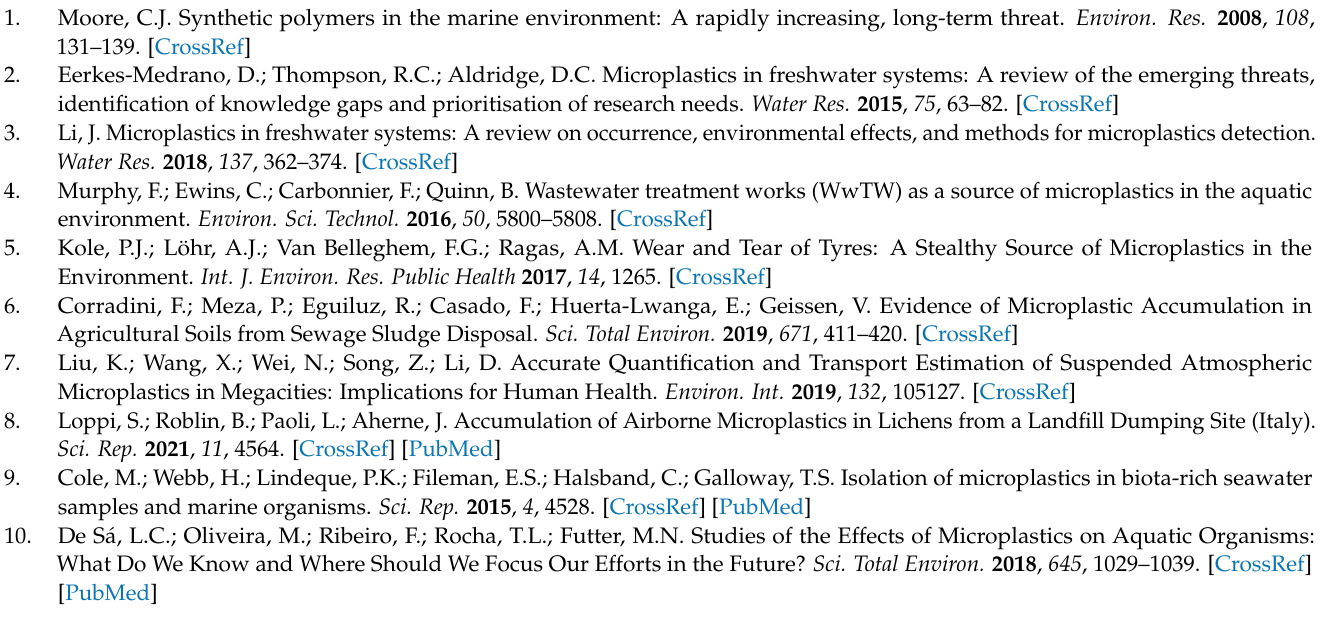
Table S3: Results from the Emmeans’